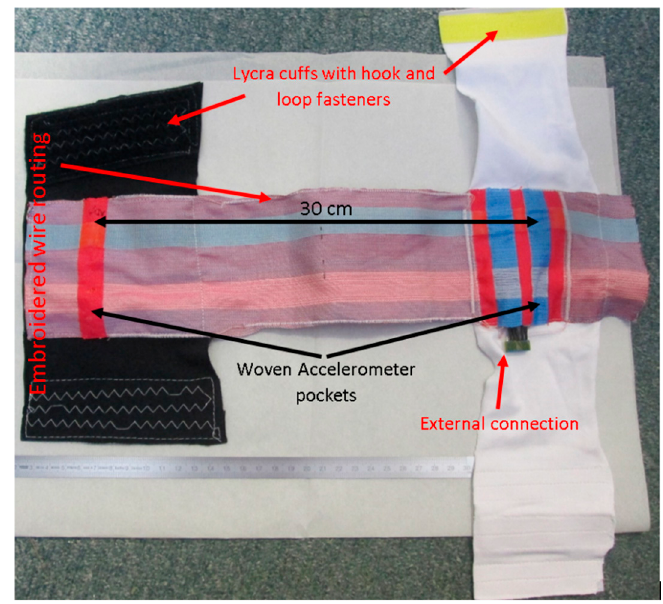
Figure 4. E-textile demonstrator with two woven accelerometers and embroidered track routing, sewn onto Lycra cuffs with hook and loop fasteners.